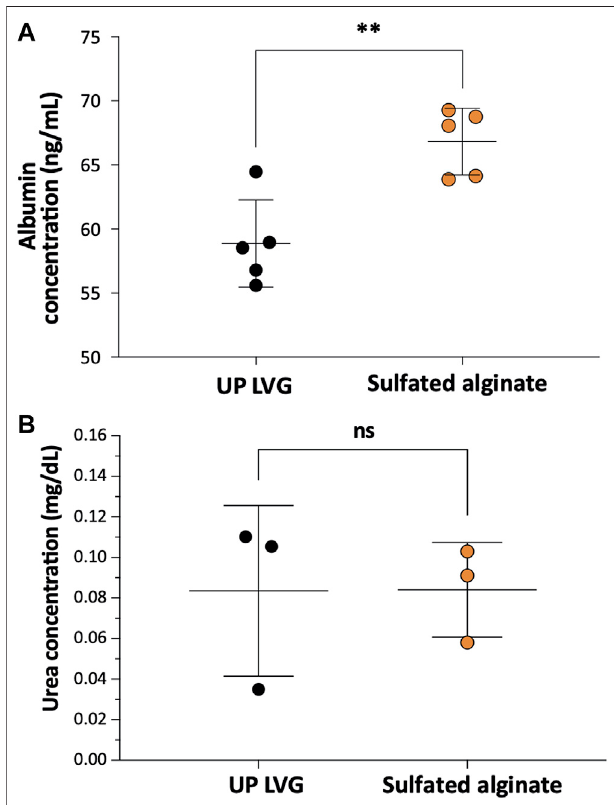
FIGURE 3 | The functionality of encapsulated hPSC-Hep spheroids. (A) Comparison of the effects of non-modi fi ed and modi fi ed alginate microbeads on albumin secretion of encapsulated hPSC-Hep spheroids ( n (cid:1) 5). (B) ComparisonofureagenesisofhPSC-HepspheroidsencapsulatedinUP LVG alginate and sulfated alginate ( n (cid:1) 3). ( p ** < 0.01, ns (cid:1) no signi fi cant